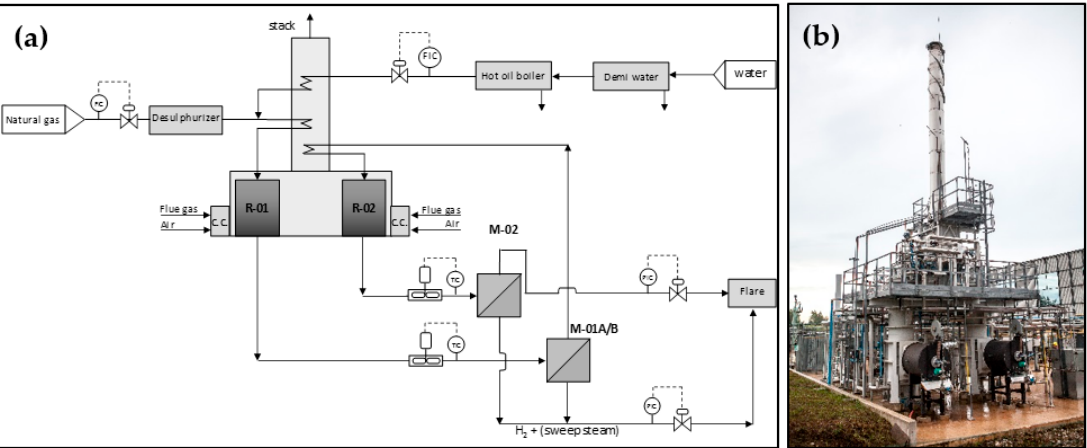
Figure 1. Pure hydrogen production membrane reactor in open architecture ( a ) Process scheme; ( b ) Bird-eye view.